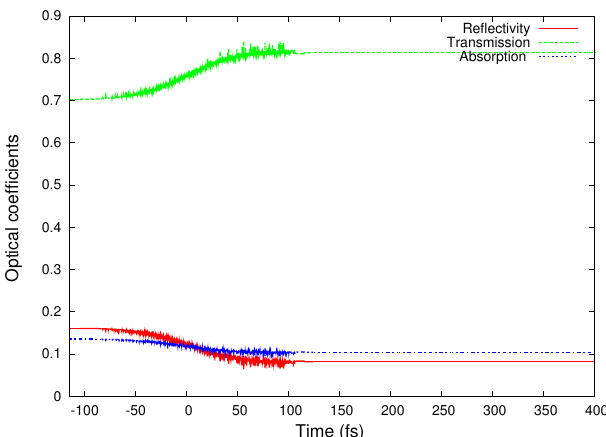
Figure 6. Optical coefficients of diamond in case of “frozen atoms” (see text) irradiated with the dose of 1.0 eV/atom. Pump pulse maximum is at t = 0 fs. The simulations were performed with 216 atoms in the